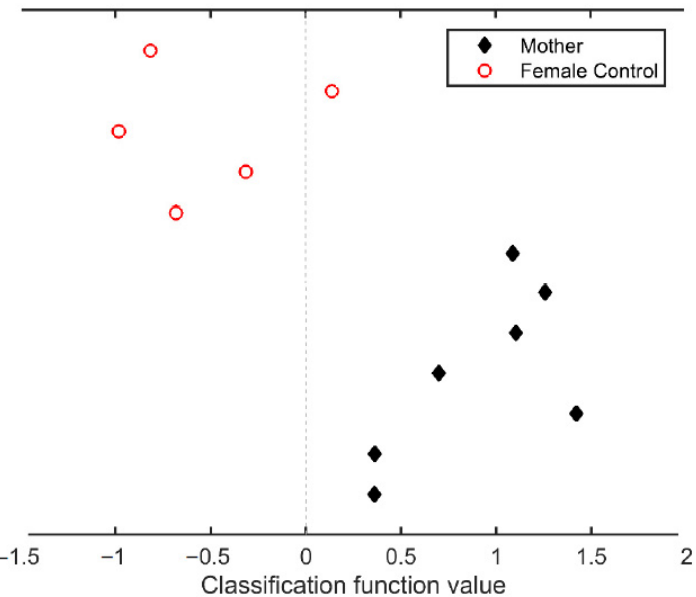
Figure 3. Classification analysis based on the gray matter volume changes between pre-pregnancy and six years after parturition sessions. Black diamonds represent the mothers, and white circles represent the nulliparous women. The dashed line is the cutoff function value between both groups. Classification function values (mean ± s.d.) for mothers and for nulliparous women are 0.899 ± 0.428 and − 0.530 ± 0.448, respectively.